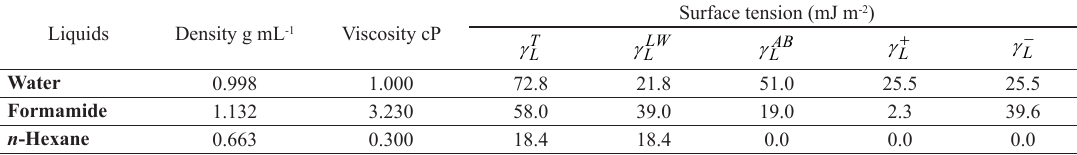
Table 1. Density, viscosity and interfacial tensions of the liquids at